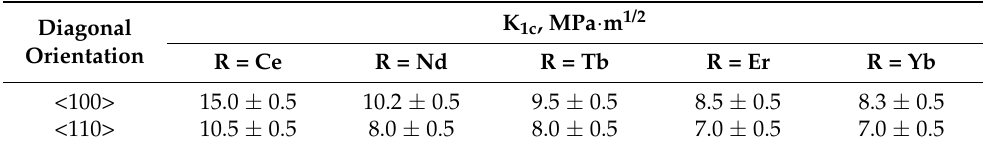
Table 3. Fracture toughness for 2Y0.8RSZ crystals (R = Ce, Nd, Tb, Er and Yb). Diagonal